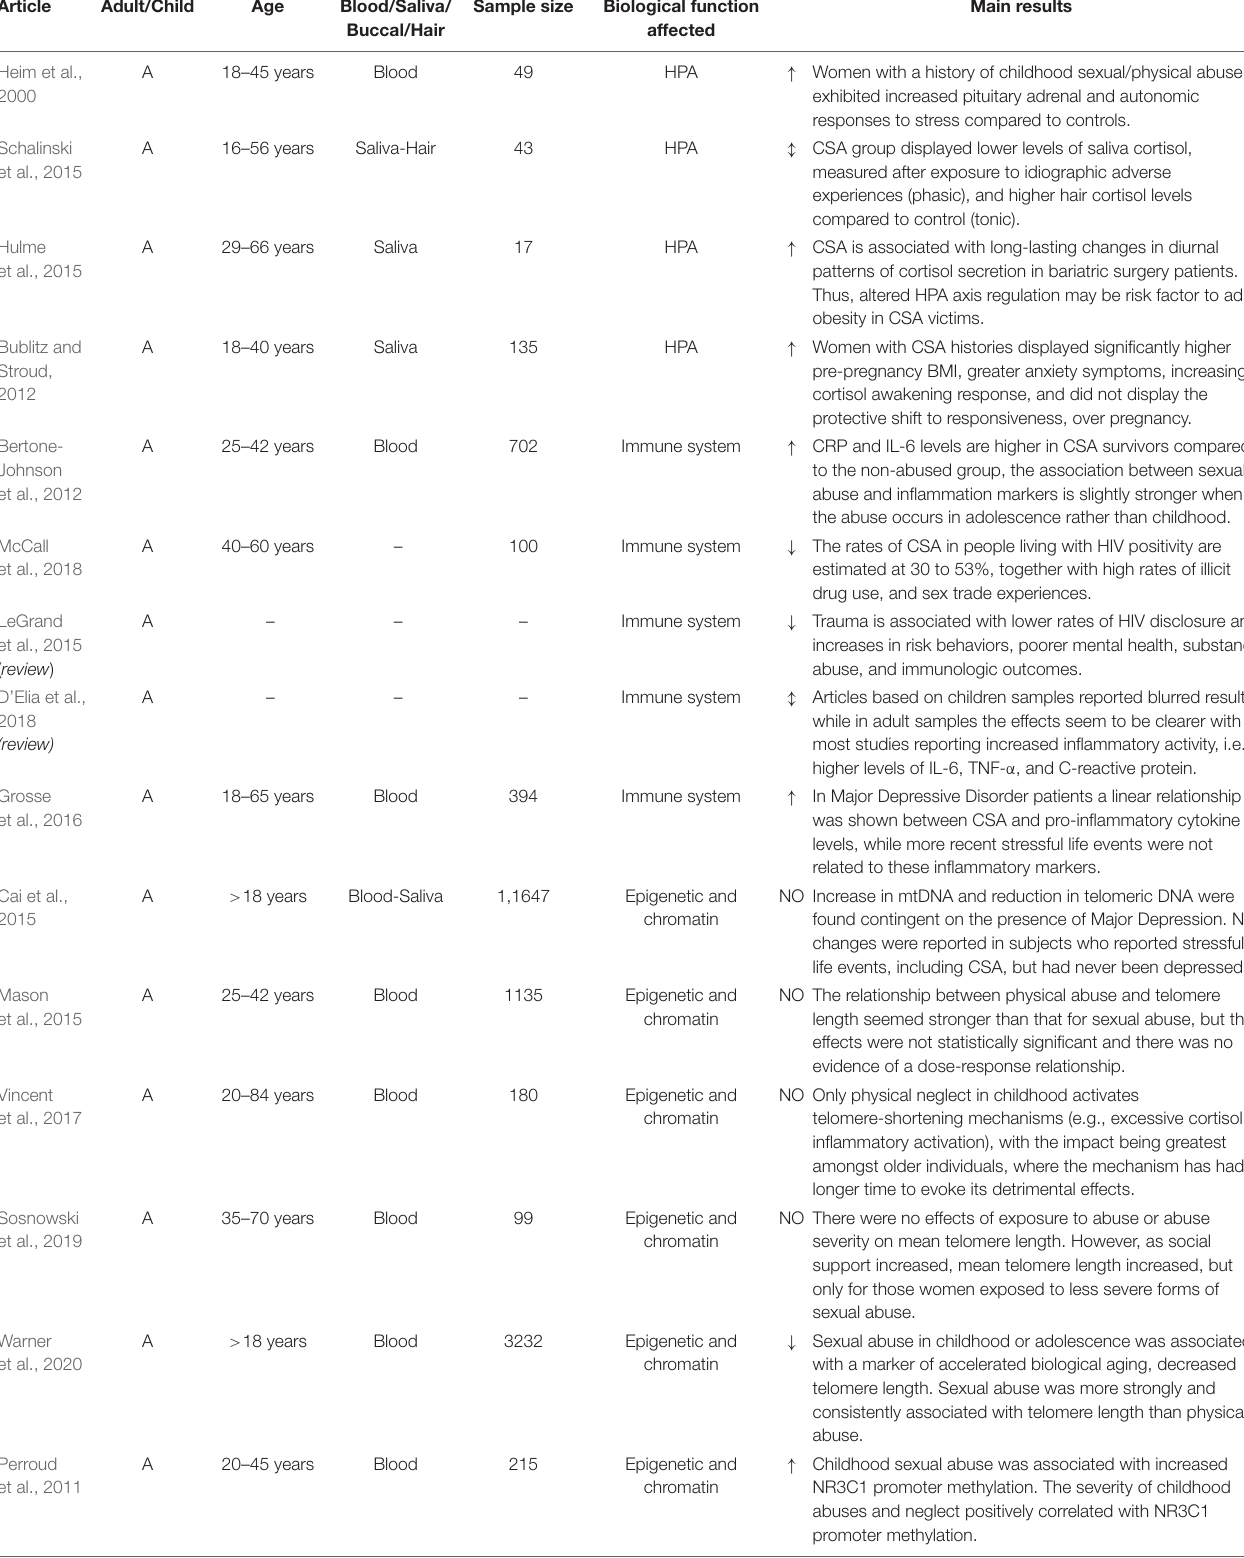
TABLE 2 | Long-term biological consequences of childhood sexual abuse (CSA)